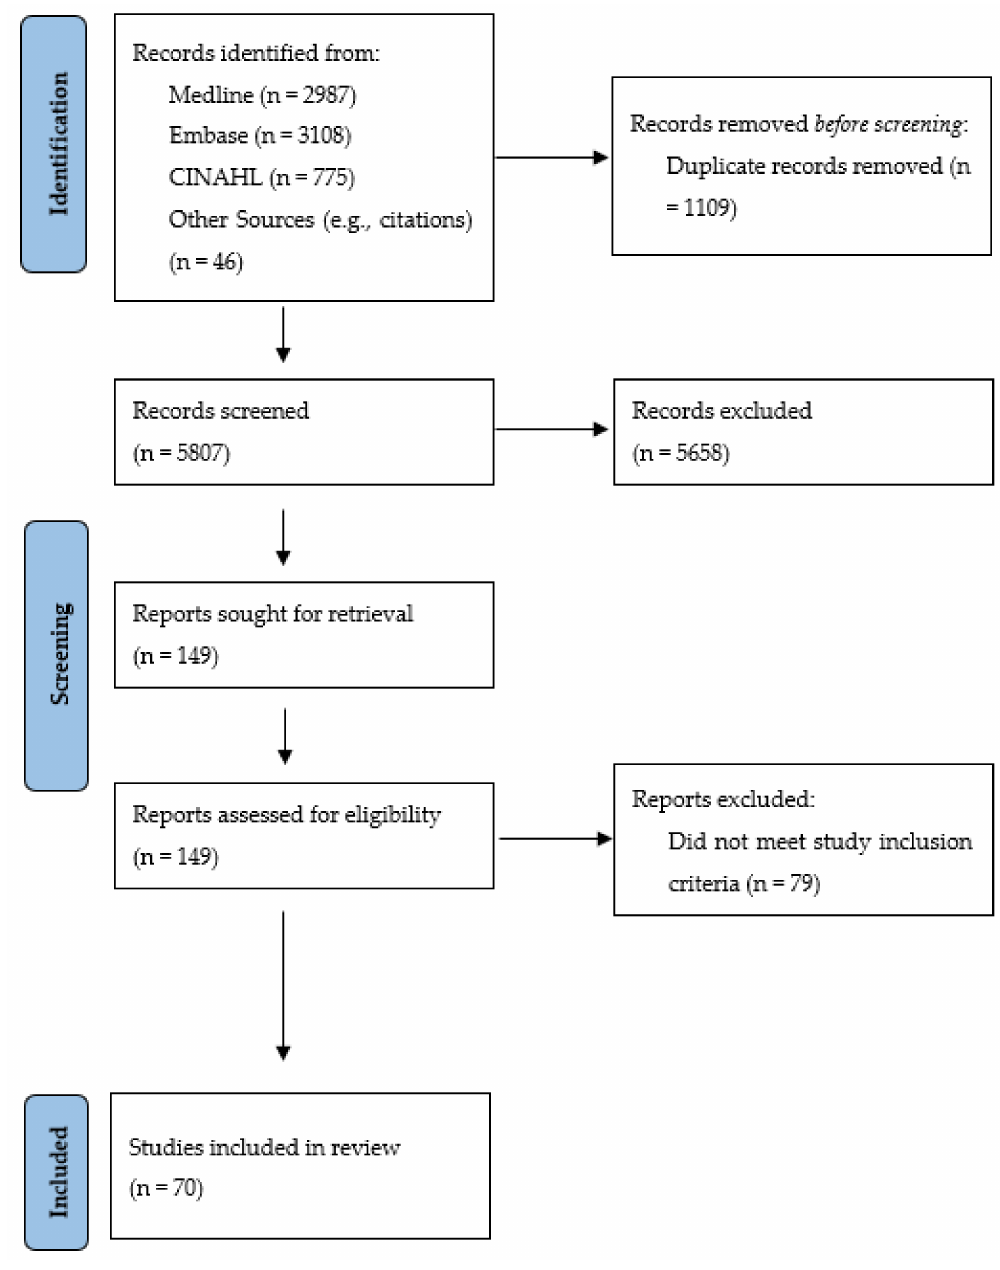
Figure 1. Search